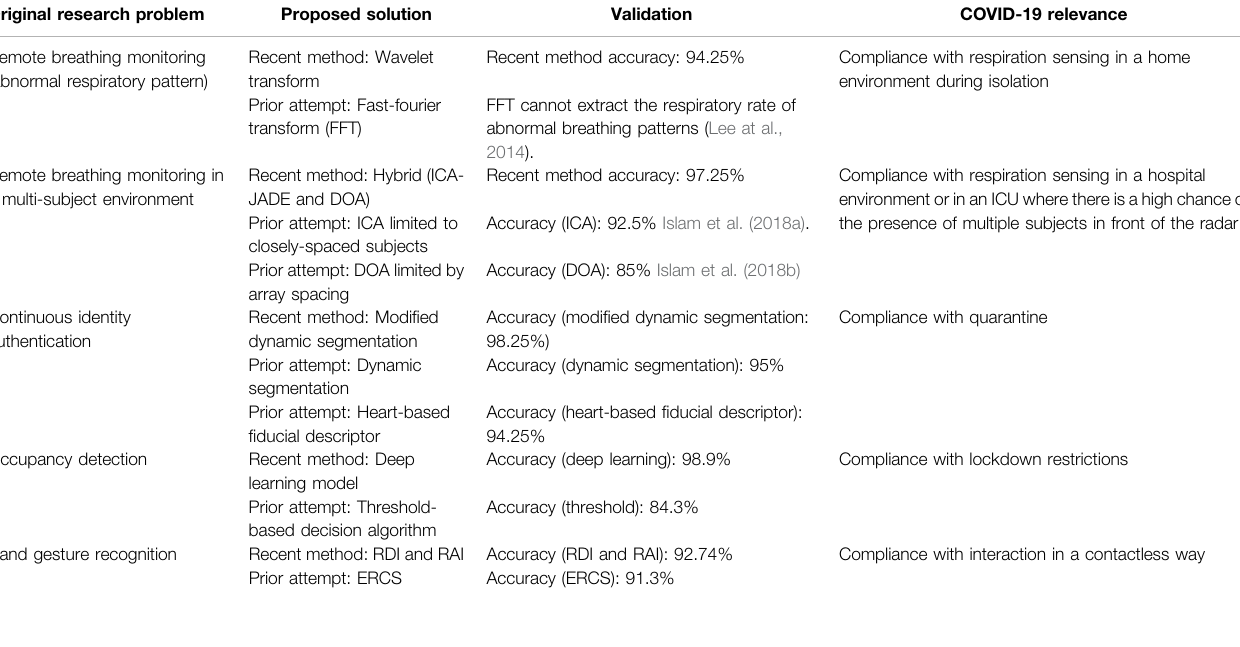
TABLE 1 | Advancement in the latest technical methods with a comparative accuracy analysis for different radar-based